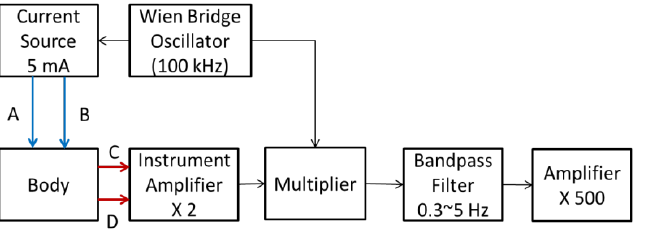
Figure 1. The block diagram of the drive circuit for the impedance plethysmography (IPG) measurement.